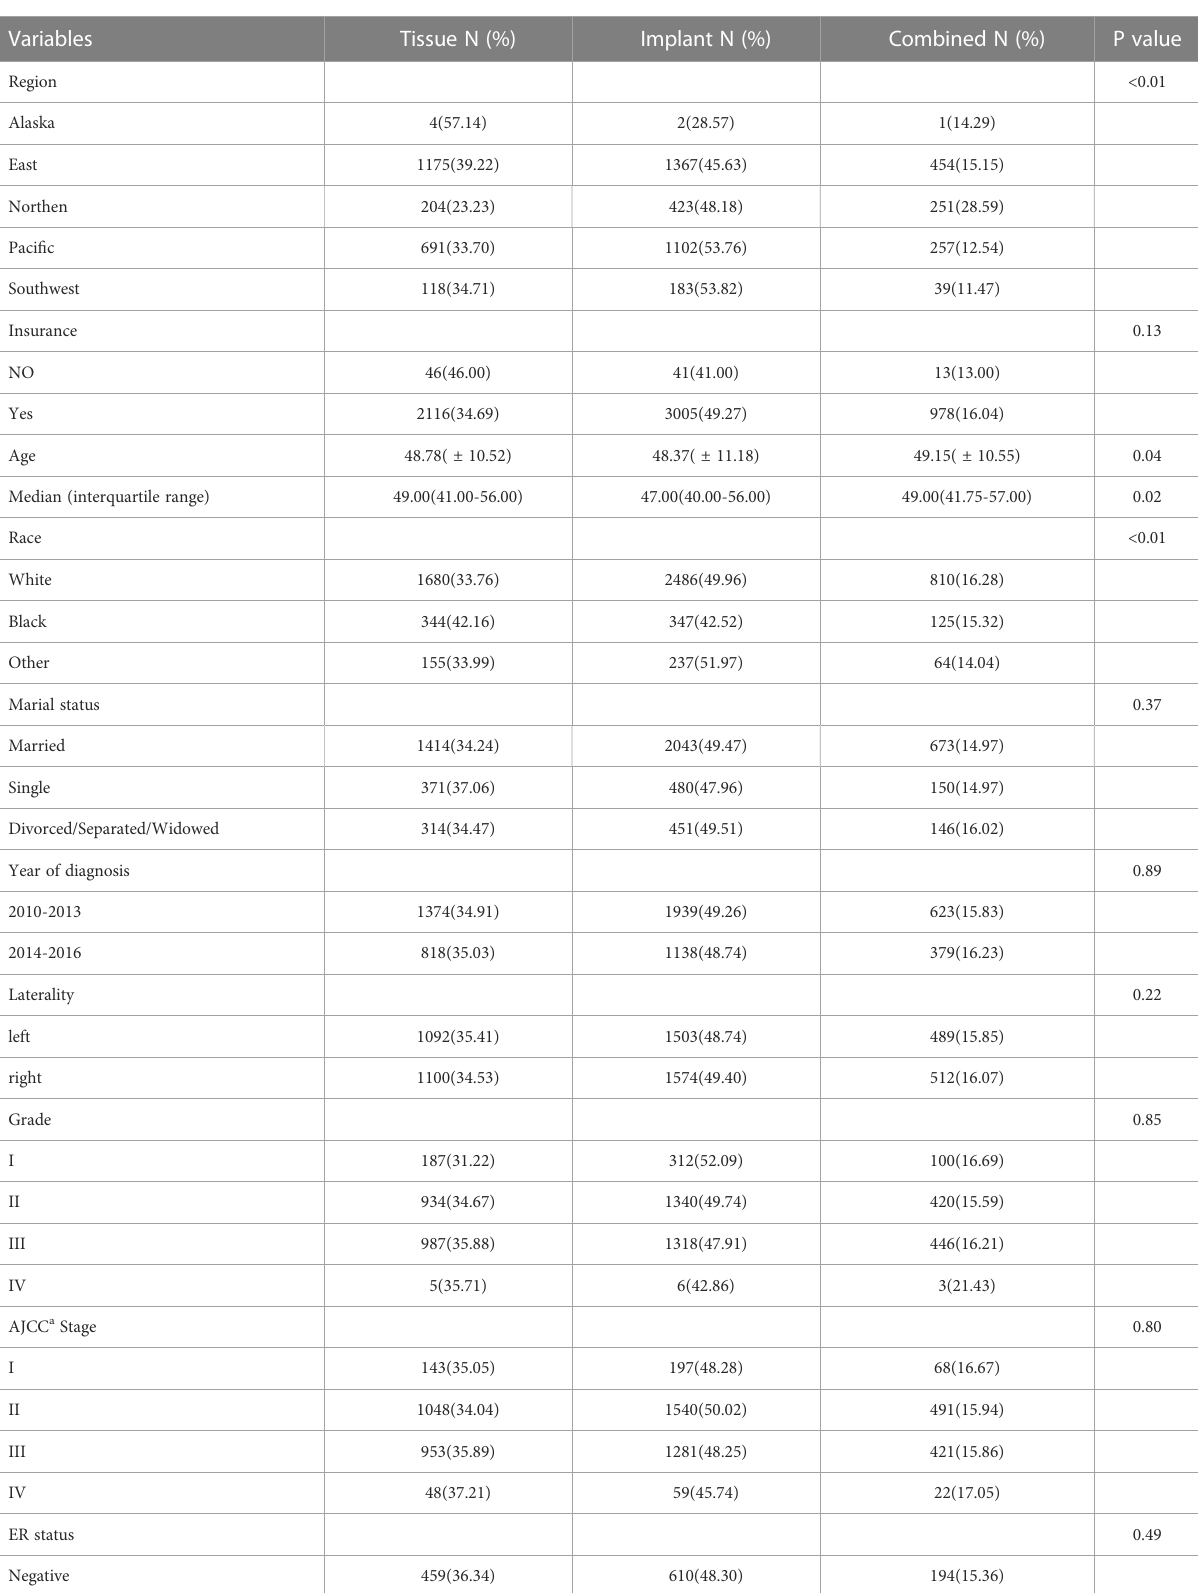
TABLE 1 Clinicopathological features of the central and nipple breast cancer